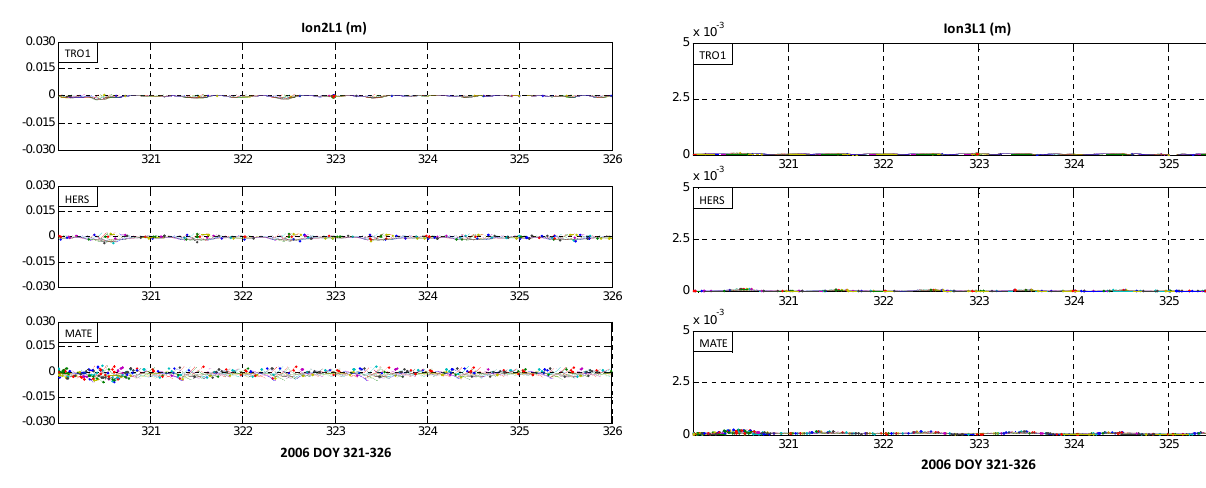
Fig. 13. Ion3 (m) for GPS L1 signal for the three observation stations on DOY 321‐326 in 2006.